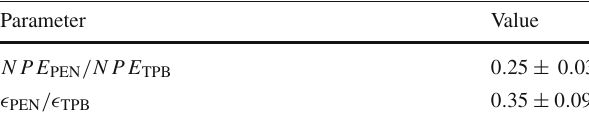
Table 4 First row: Value of the relative photon detection efficiency, N